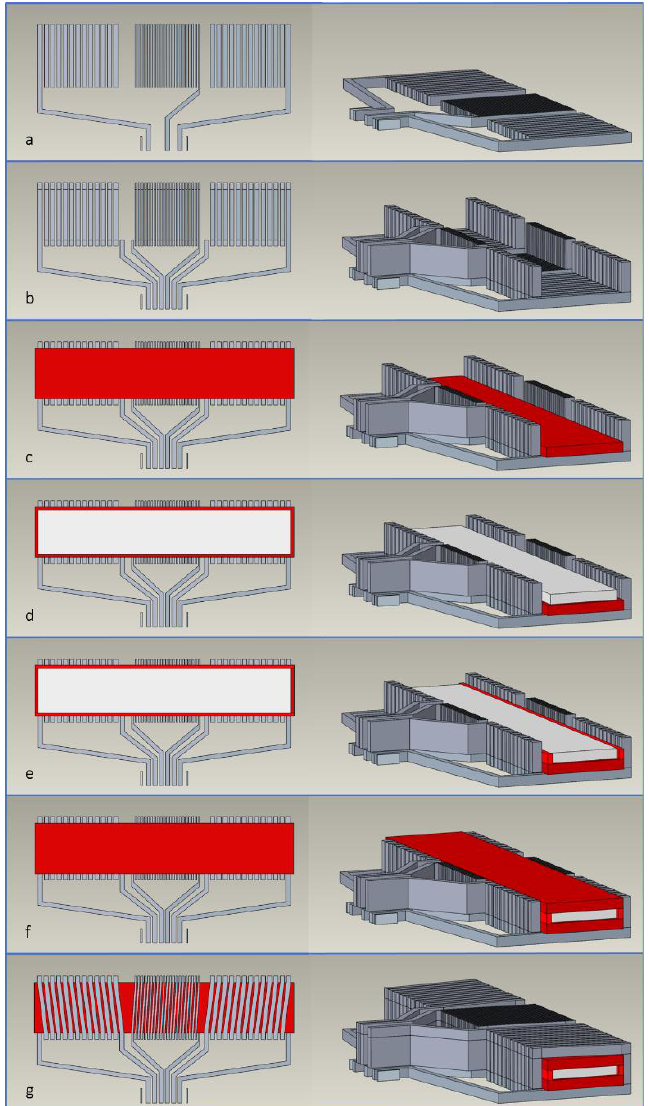
Figure 2. Schematic representation of the sensor after each fabrication step: ( a ). First step: printing the bottom conductive layer; ( b ). Second step: printing the conductive vias; ( c ). Third step: printing the bottom insulating layer; ( d ). Fourth step: the mounting and attachment of the magnetic core; ( e ). Fifth step: printing the insulating walls and ( f ) the top insulating layer; ( g ). Sixth step: printing the top conductive layer.